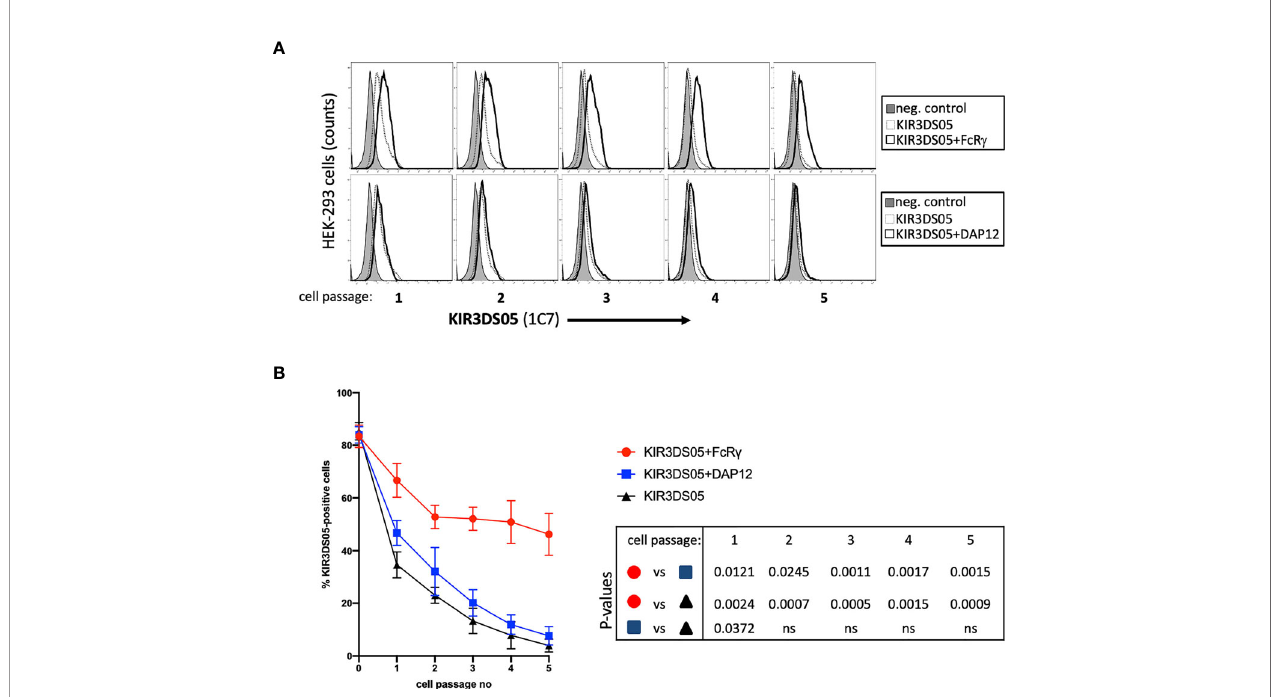
FIGURE 4 | Stability of AcGFP-tagged KIR3DS05 expression in the presence of myc-tagged FcR g and DAP12 adaptor proteins. HEK-293 cells stably transfected with AcGFP-tagged KIR3DS05 either alone or in combination with either myc-tagged FcR g or DAP12 adaptor proteins were followed for KIR3DS05 expression over time (one cell passage corresponds to 2-3 days). (A) Flow cytometric analysis of KIR3DS05 cell surface expression measured with antibody 1C7 after each passage of the cells. (B) Identical percentages of KIR3DS05-positive proteins were used as starting point (passage 0) and expression of KIR3DS05 (% positive cells) was measured after each passage of the cells. The results of three independent experiments and of unpaired t tests are shown (ns, not signi fi